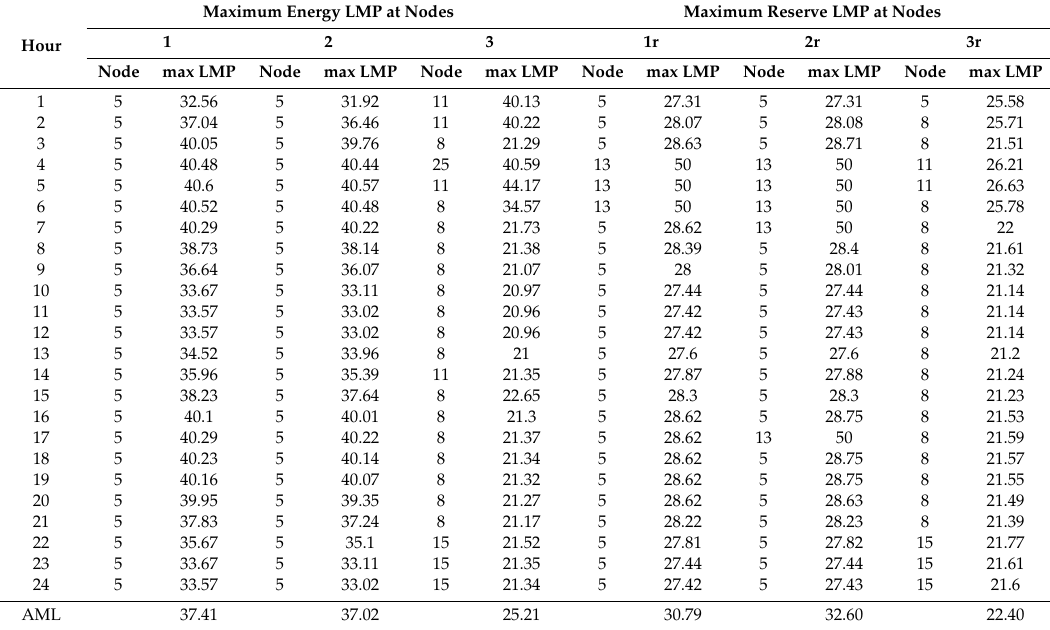
Table 2. LMP and LCMRP of various market models for the day-ahead